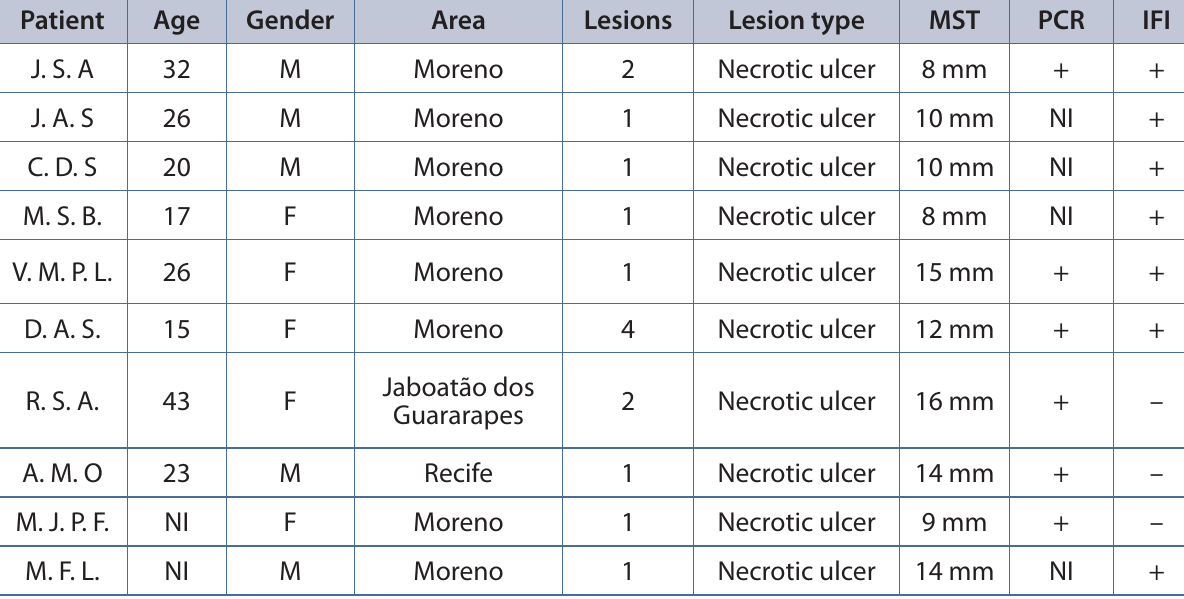
MST: Montenegro skin test; PCR: detection of the parasites by polymerase chain reaction; IFI: immunoglobulin detection by indirect immunofluorescence; +: positive; –: negative; NI: not